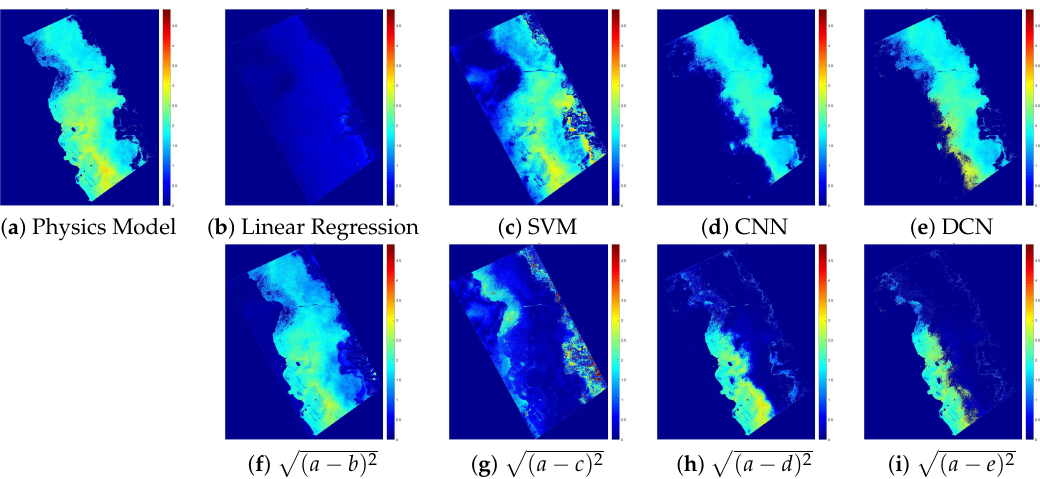
Figure 9. LAI mapping at Keeton Beach produced by models trained with patches from the selected regions. No mask was applied in this